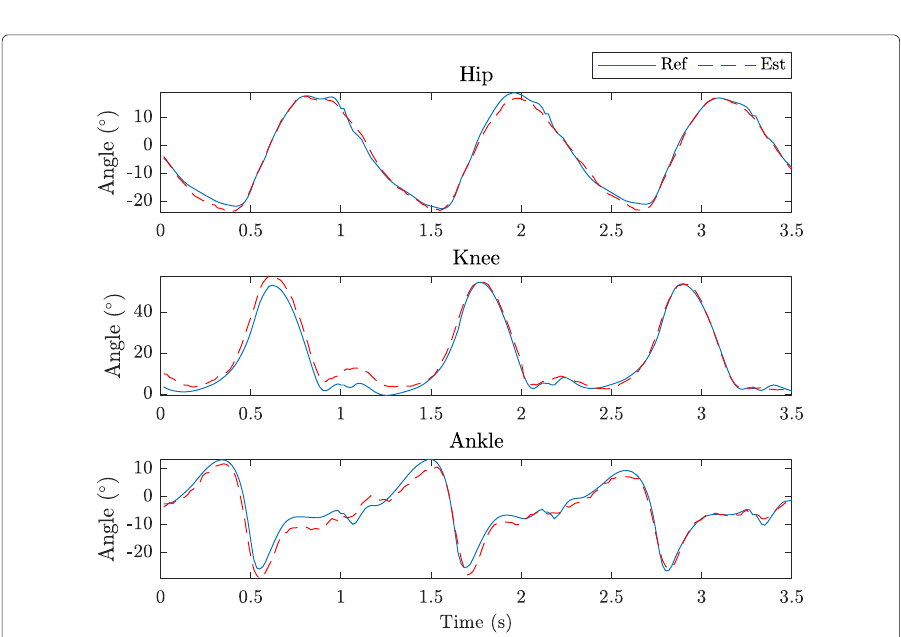
Fig. 11 Estimated lower limb joint angles in the sagittal plane using the LSTM with input set 4 and the reference lower limb joint angles from the wearable system. Blue solid lines and red dashed lines are the reference and the estimated joint angles,